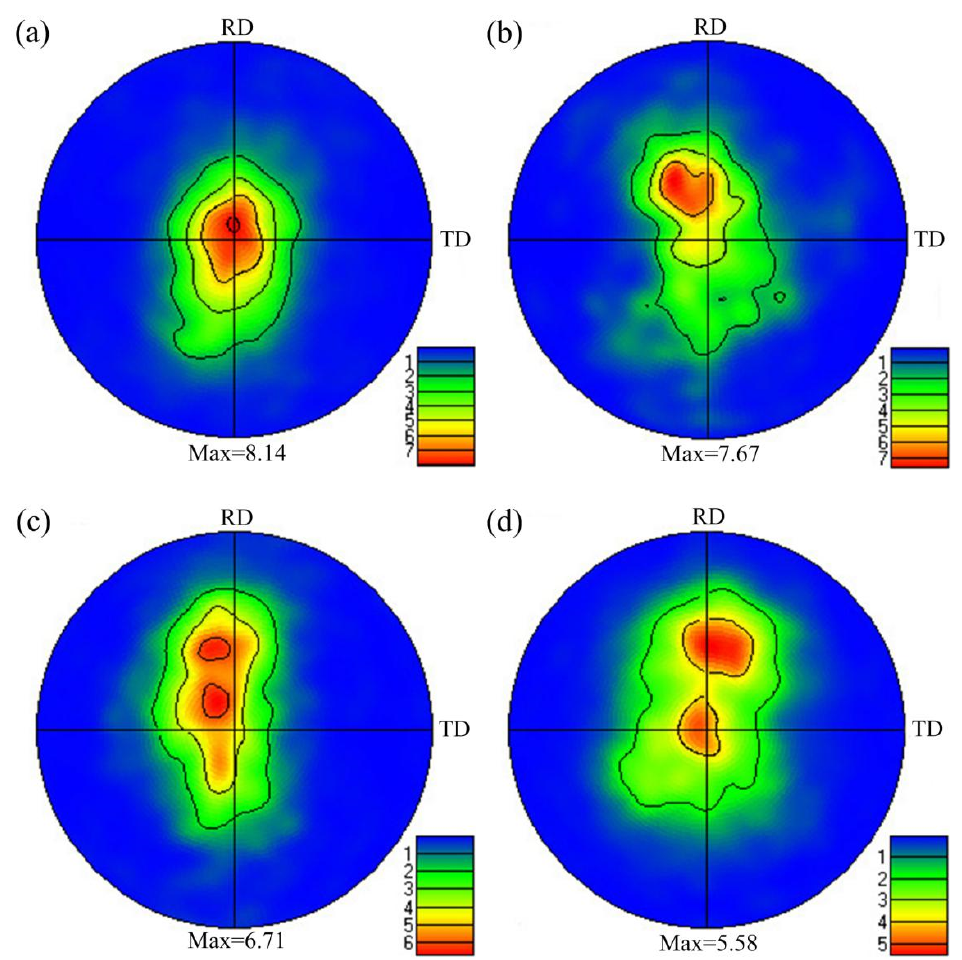
Figure 4. Pole figure detected by electron back-scatter diffraction (EBSD) in AZ31 alloys HSRMFed at different temperatures as Δε = 1.32: ( a ) 250 °C, ( b ) 300 °C, ( c ) 350 °C, ( d ) 400 °C.